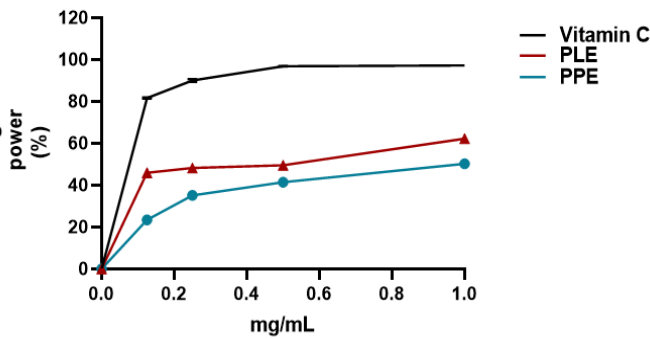
Figure 3. Ferric reducing antioxidant power (FRAP) assay of PPE and PLE. Results were expressed as mean radical scavenging activity percentage (%) ± standard deviations (n = 3). Ascorbic acid was used as the reference standard.